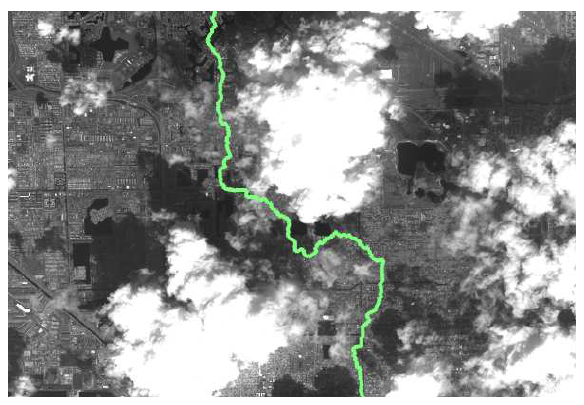
Figure 7. Stiching line avoiding